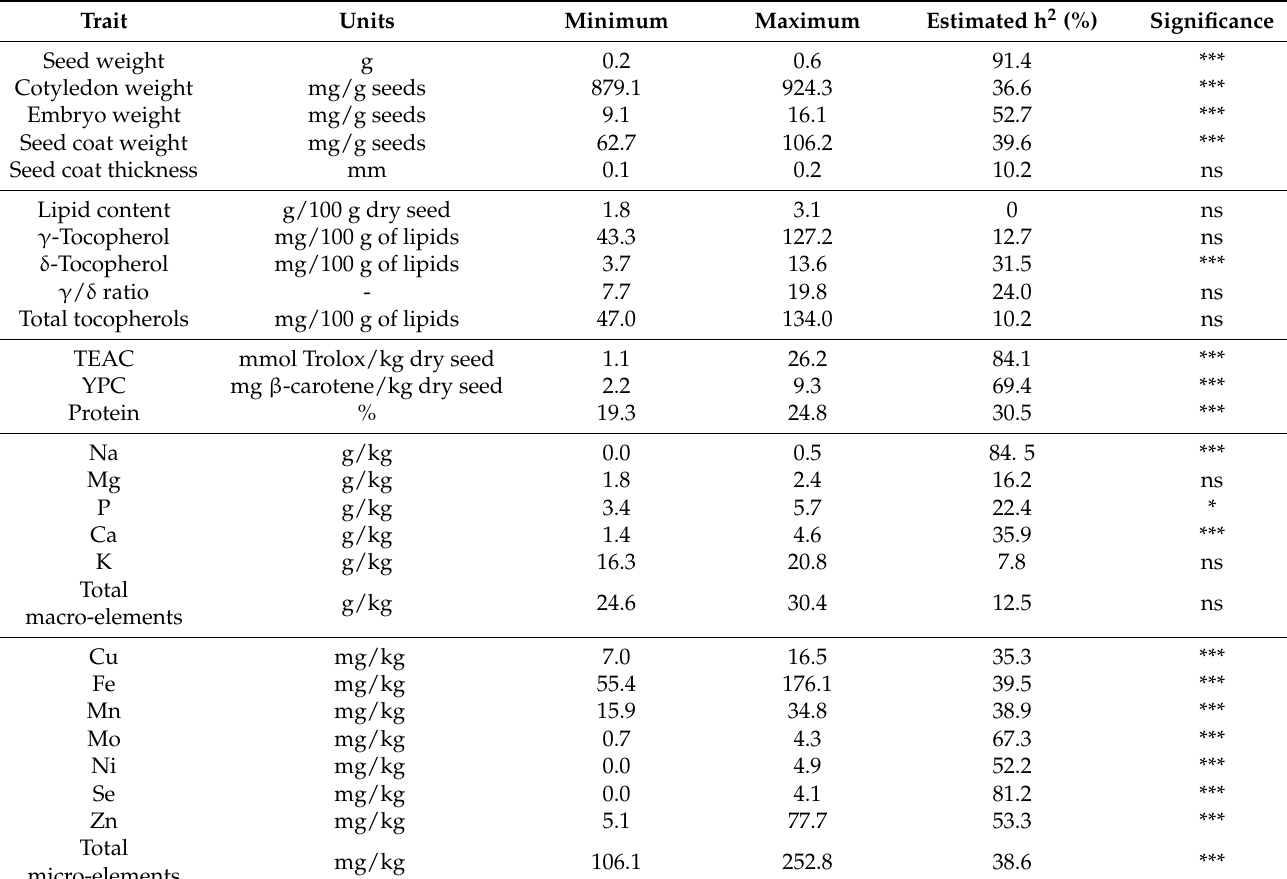
Table 2. ANOVA for the morphological and compositional traits